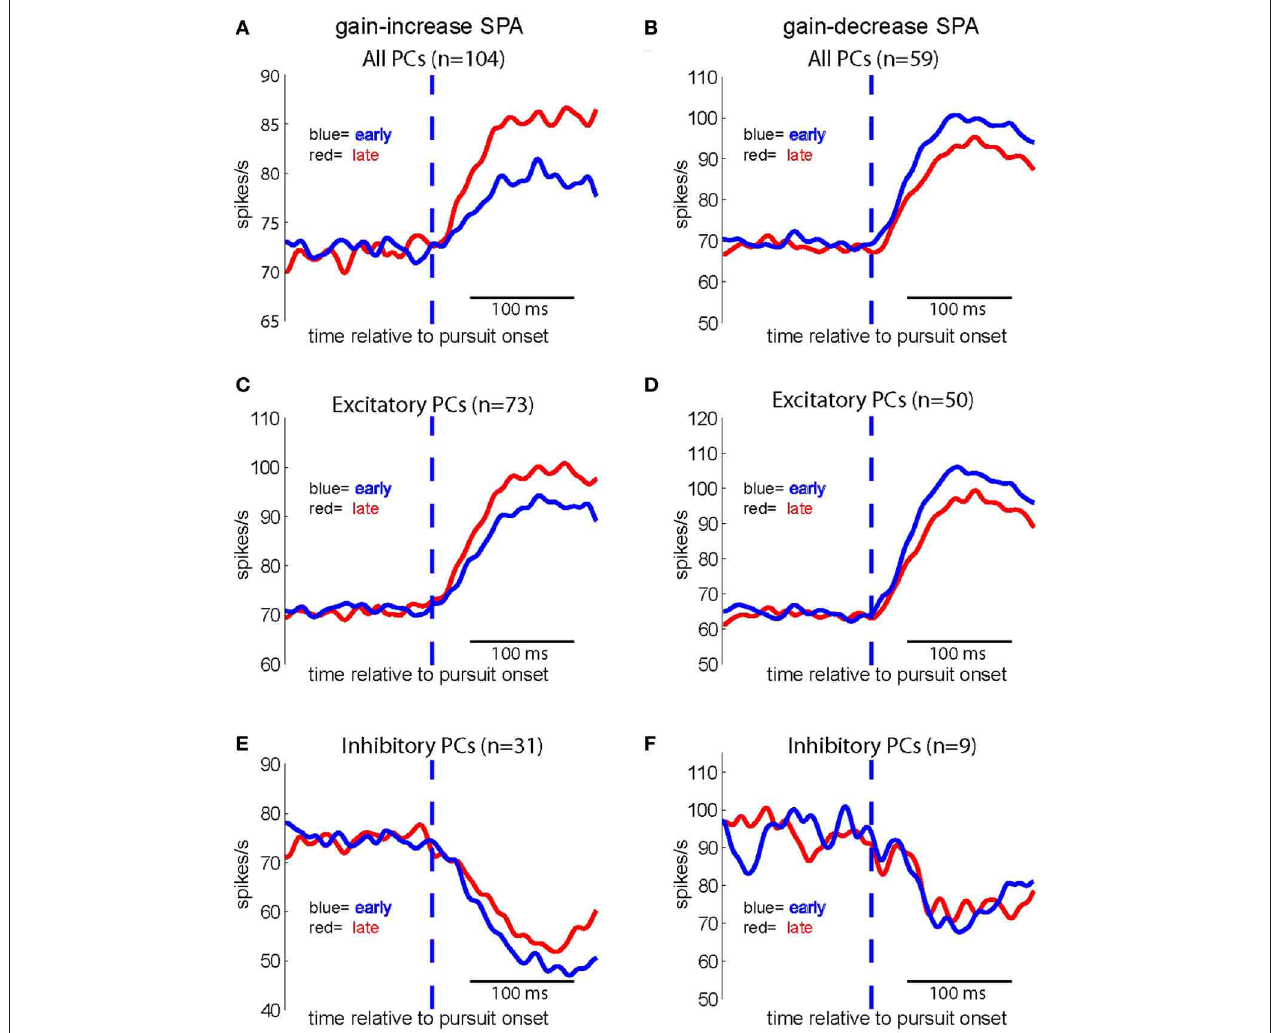
FIGURE 6 | Population spike density functions for different groups of PC SS subjected to either gain increase (left panels) or to gain decrease SPA (right panels) for the first (red) and the last quarter of trials (blue). Upper row: population spike density functions based on all PC SS tested for gain-increase SPA ( n = 104) (A) and gain-decrease SPA